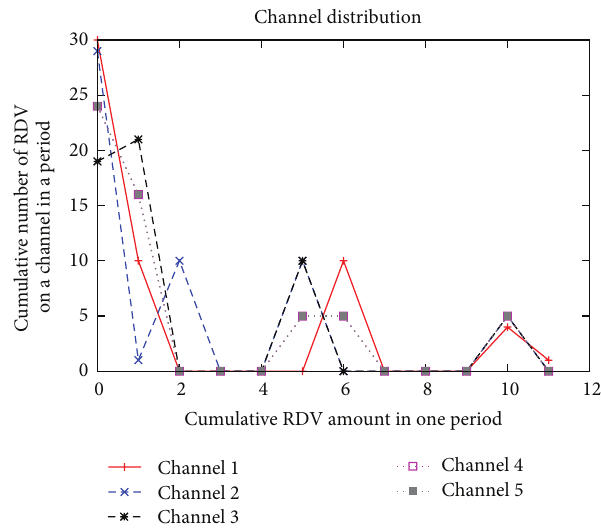
Figure 19: A-ETCH with the different sequences (5 channels).